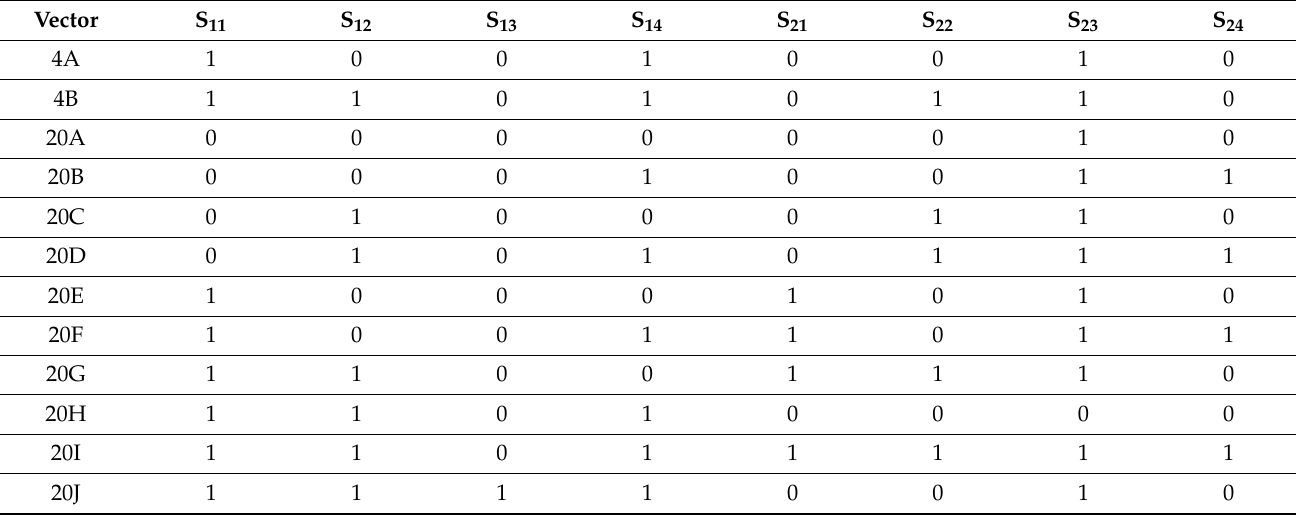
Table 4. Redundant vectors for the case of ν α = +2, ν β = +1 and ν o =